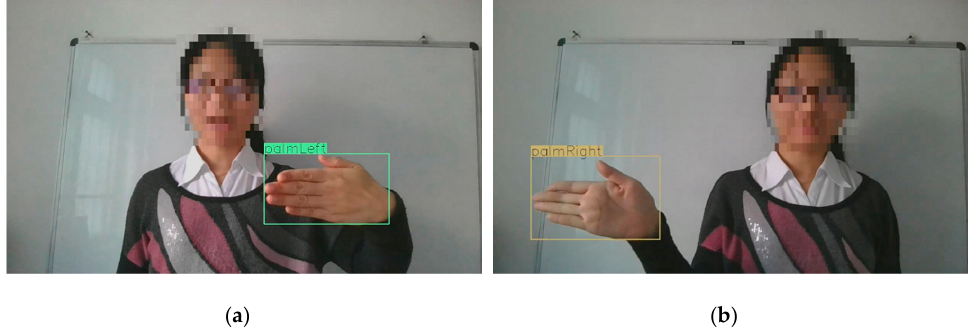
fails. ( a ) The hand posture is incorrectly classified; ( b ) the hand posture is correctly classified.